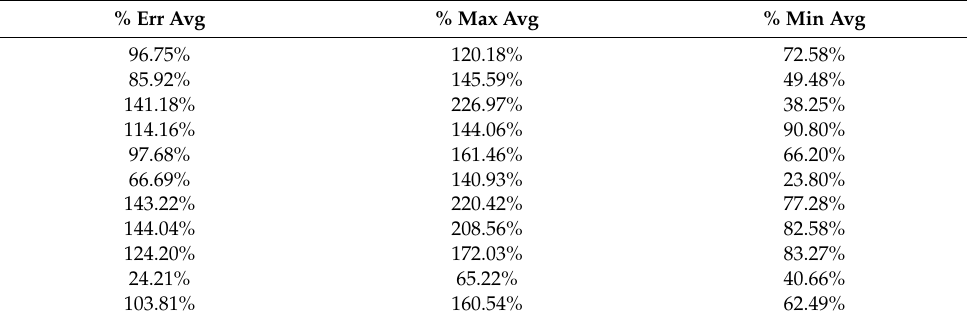
Table A106. Set 2, trials 11–20 data (average actual PR values).